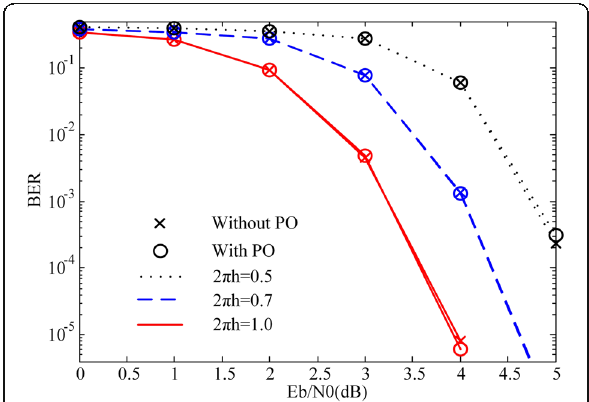
Fig. 5 BER performance of CE-OFDM with and without phase offset. Detailed legend: the cross represents simulation without phase offset and the circle represents simulation with phase offset. The dotted line, the broken line, and the full line represents 2 π h =0.5, 0.7, and 1.0, respectively Fig. 6 BER Performance of CE-OFDM in multipath